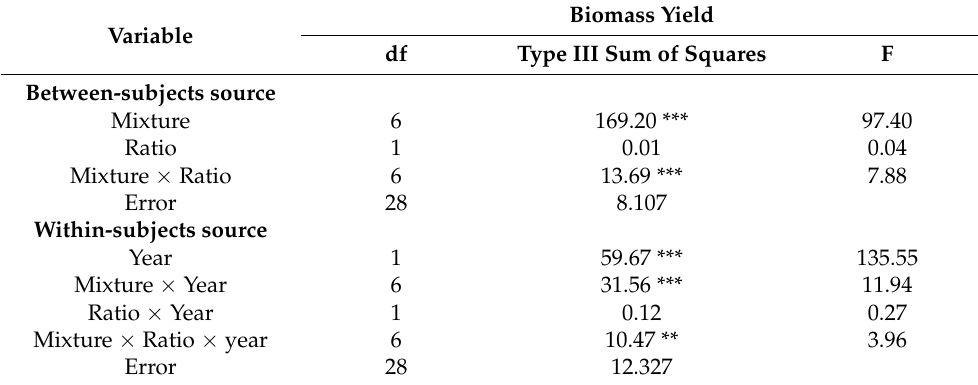
Table 3. Repeated-measures ANOVA for the effects of mixture composition and legume-grass seeding ratio on the biomass yield in 2018 and